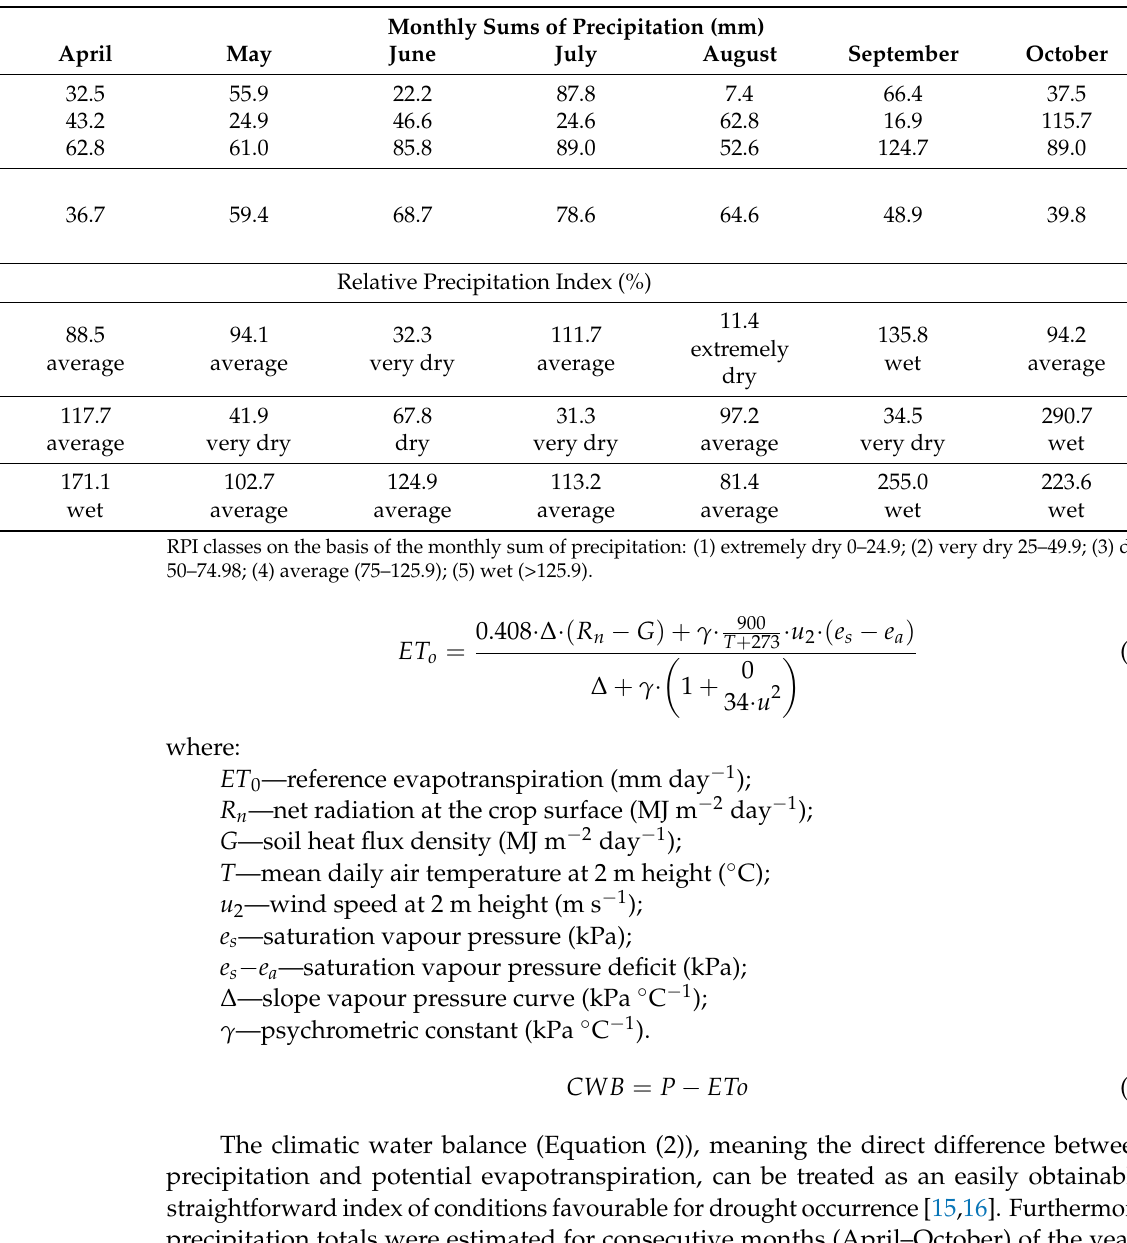
Table 2. Distribution of the precipitation data in the years from 2015 to 2017 in light of the long-term precipitation